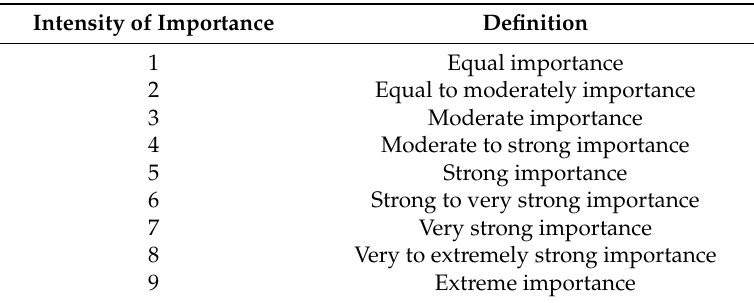
Table 2. Scale of relative significance for pair wise comparison